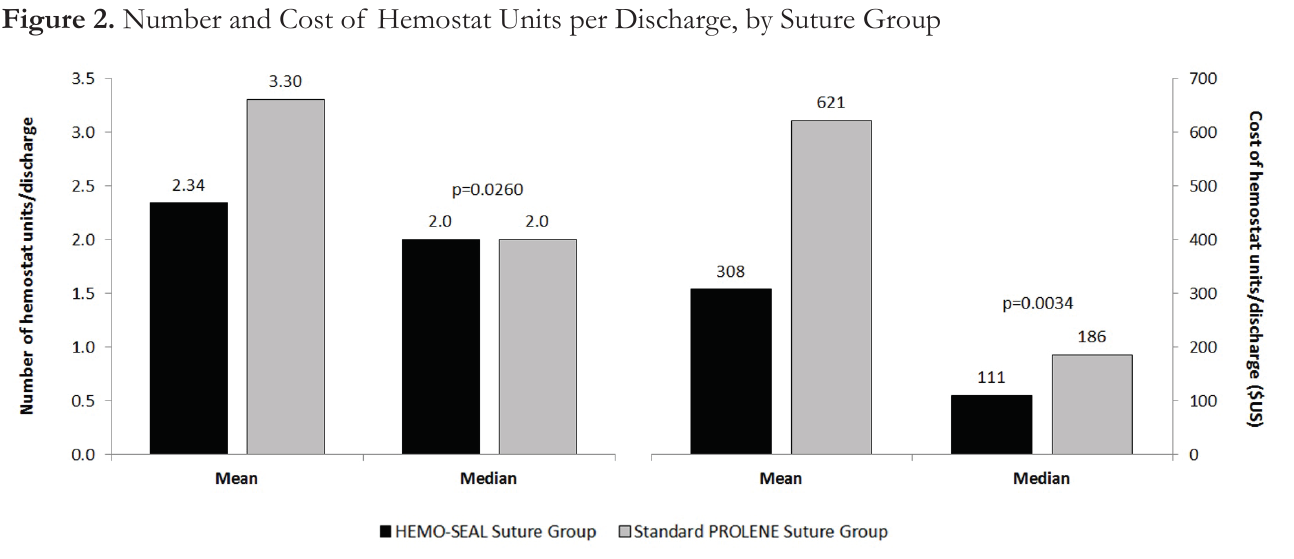
P-values calculated using two-sided Wilcoxon rank sum test and compared against the p<0.05 significance